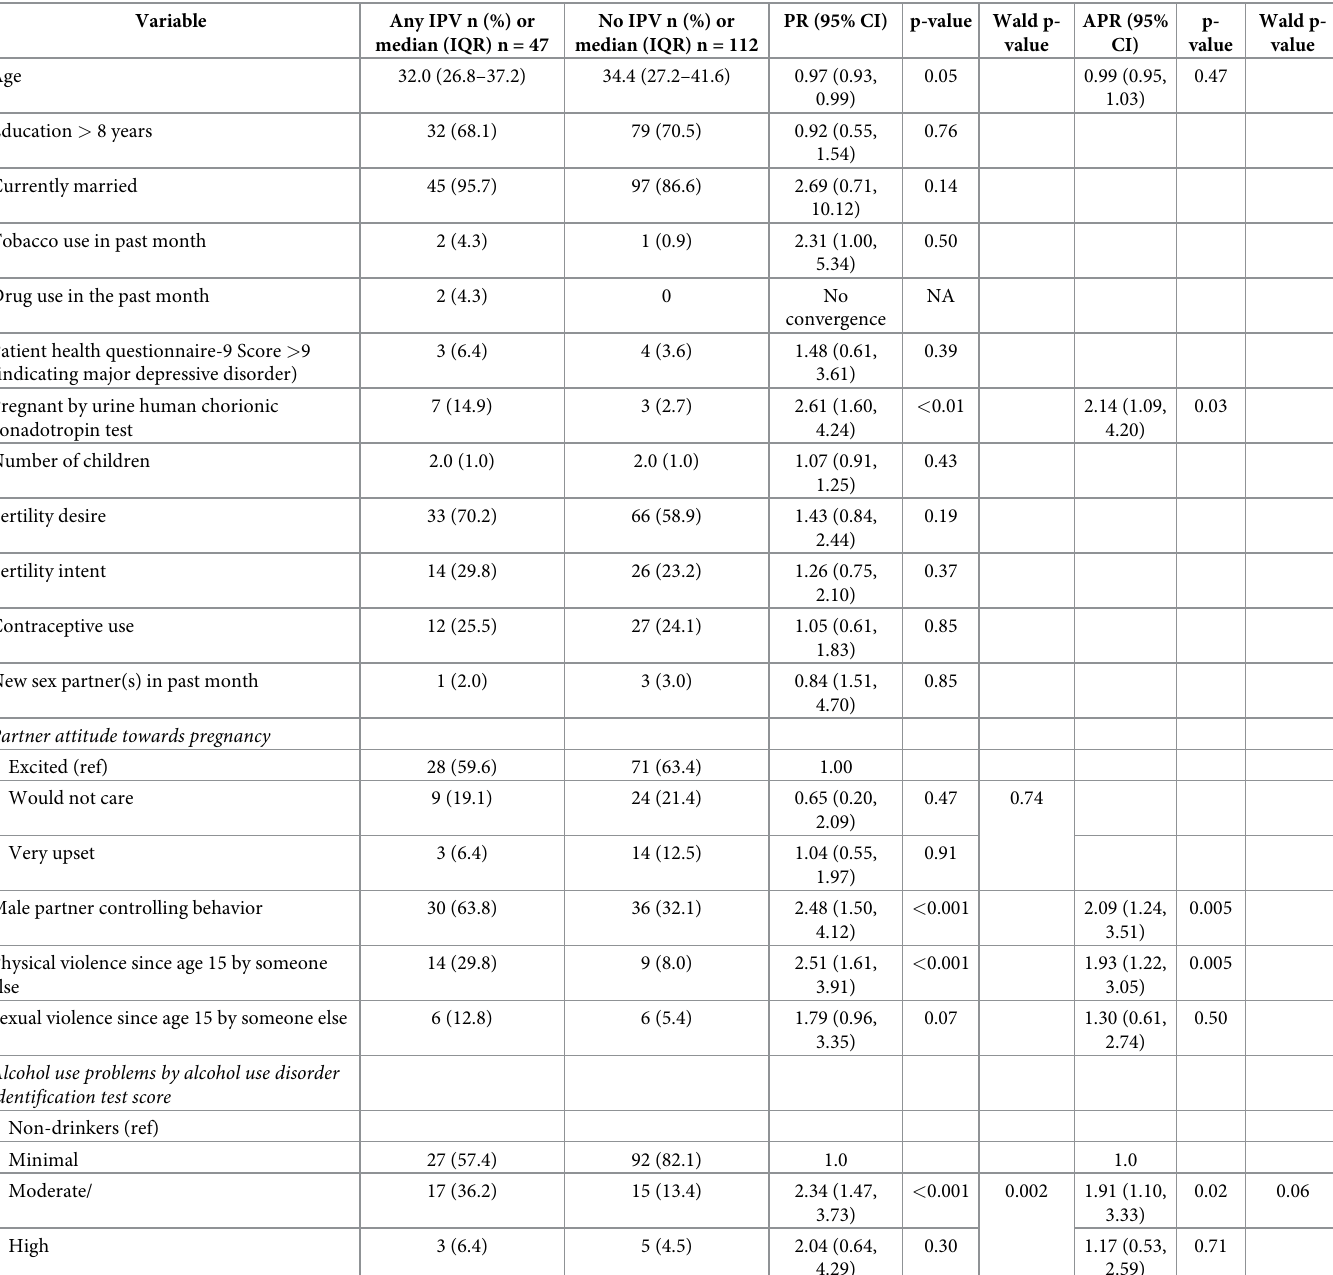
Table 2. Correlates of any IPV in the past 12 months by the current